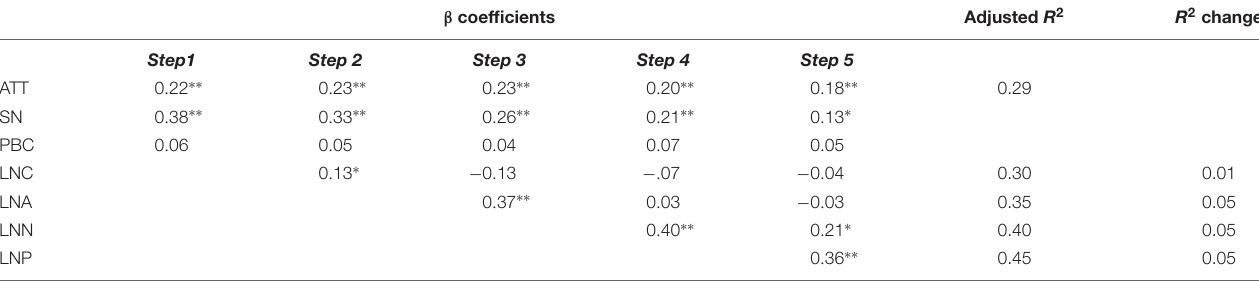
TABLE 6 | Hierarchical regression analysis predicting Intentions to participate in household waste recycling on sample 1 ( N = 222).